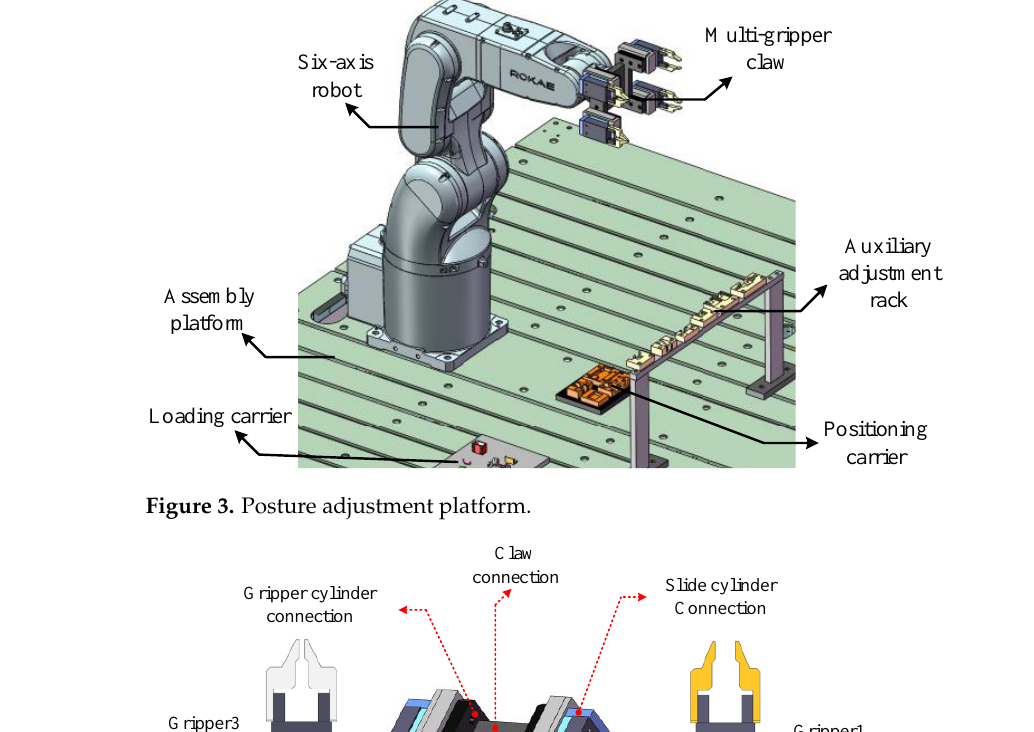
Figure 3. Posture adjustment platform.